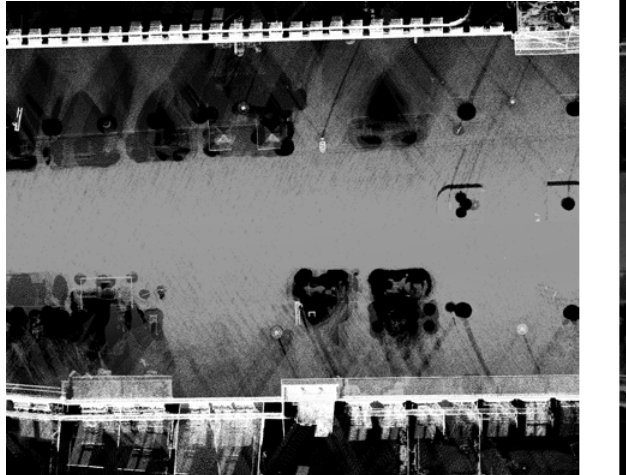
Figure 6. Resulting height reference image. Figure 7. Resulting intensity reference image.